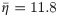
Estimating the stoichiometry of HIV-1 nAb neutralization (N) with mixed trimer assays.(A) Scheme depicting the combined experimental-mathematical approach employed here to estimate N. (B) Neutralization by nAb 2F5 of mixed trimer HIV-1 pseudovirus stocks containing the indicated ratios of JR-FL wt (2F5 sensitive) and JR-FL D664N (2F5 resistant) Envs. The relative infectivity (RI) of each stock is given by the percentage of target cell infection (i.e., the inverse of % neutralization) under saturating 2F5 nAb concentrations. (C) Theoretical model predictions of the relation between N (N = 1, 2 or 3; colored lines) and RI of virus stocks with different fractions of neutralization-sensitive to resistant Env (fR). The experimental JR-FL nAb 2F5 RI data from (B) are plotted as black dots, representing two independent experiments. Data fitting resulted in an estimate of N = 1, assuming T = 2 and η¯=11.8 trimers for each JR-FL virion (S3 Table). (D) Robustness analysis for the N = 1 estimate of HIV-1 strain JR-FL and nAb 2F5 against variation in T and η¯. Blue areas show combinations of T and η¯ resulting in estimates of N = 1, green areas show combinations of T and η¯ that would result in estimates of N = 2. The actual values of T and η¯ for JR-FL (see above) are marked by the white dot, indicating that the N = 1 estimate is robust. (E) Since the model fit shown in (C) for JR-FL and nAb 2F5 is imperfect, we analyzed the goodness-of-fit. A slightly reduced η¯ or slightly increased T compared to those used for the analysis (white dot, S3 Table) could improve the model fit to the experimental data.